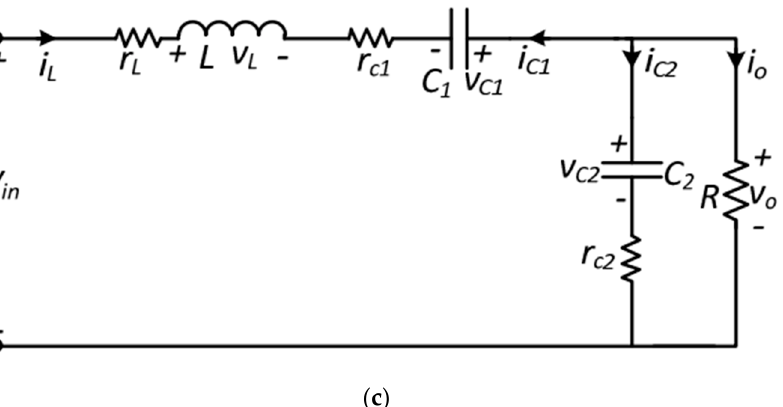
Figure 4. ( a ) Circuit diagram of the super-lift Luo Converter; ( b ) circuit when S is ON; ( c ) circuit when S is OFF